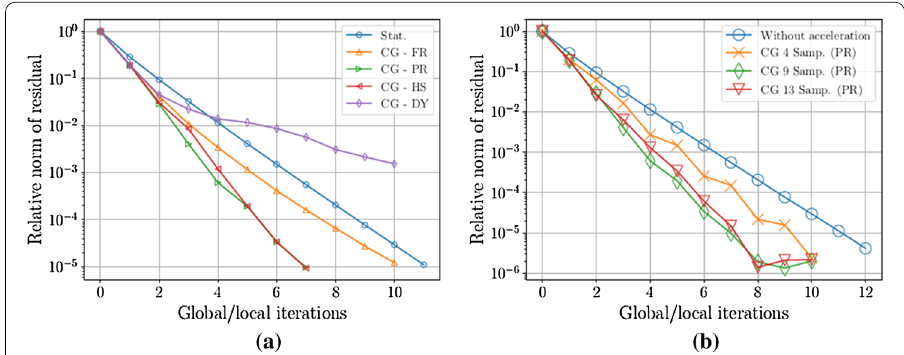
Fig. 5 Study of variants of nonlinear conjugate gradient. a Performance of conjugation formulas. b Influence of the linesearch sampling